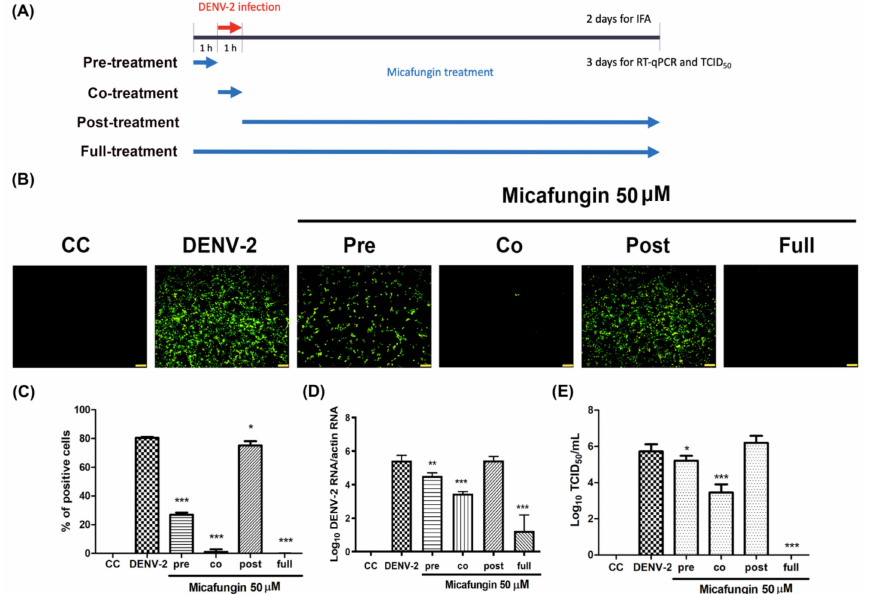
Figure 2. Time-of-addition assay of micafungin: ( A ) timeline of time-of-addition assay; ( B ) IFA results indicating DENV-2 infection; ( C ) quantitative analysis using ImageJ software; RNA level ( D ) and viral yield ( E ), as detected using RT-qPCR and TCID 50 assays. All data were obtained from at least three independent experiments, where significance was indicated as follows: * p < 0.05; ** p < 0.01; *** p < 0.001. Scale bar: 100 µ